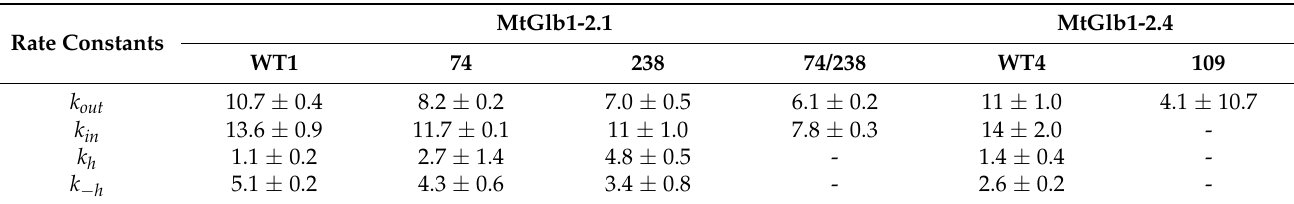
Table 2. Activation energies (kcal/mol) determined from Arrhenius plots in the temperature range 10–40 ◦ C. Microscopic rate constants are retrieved from the fit of LFP